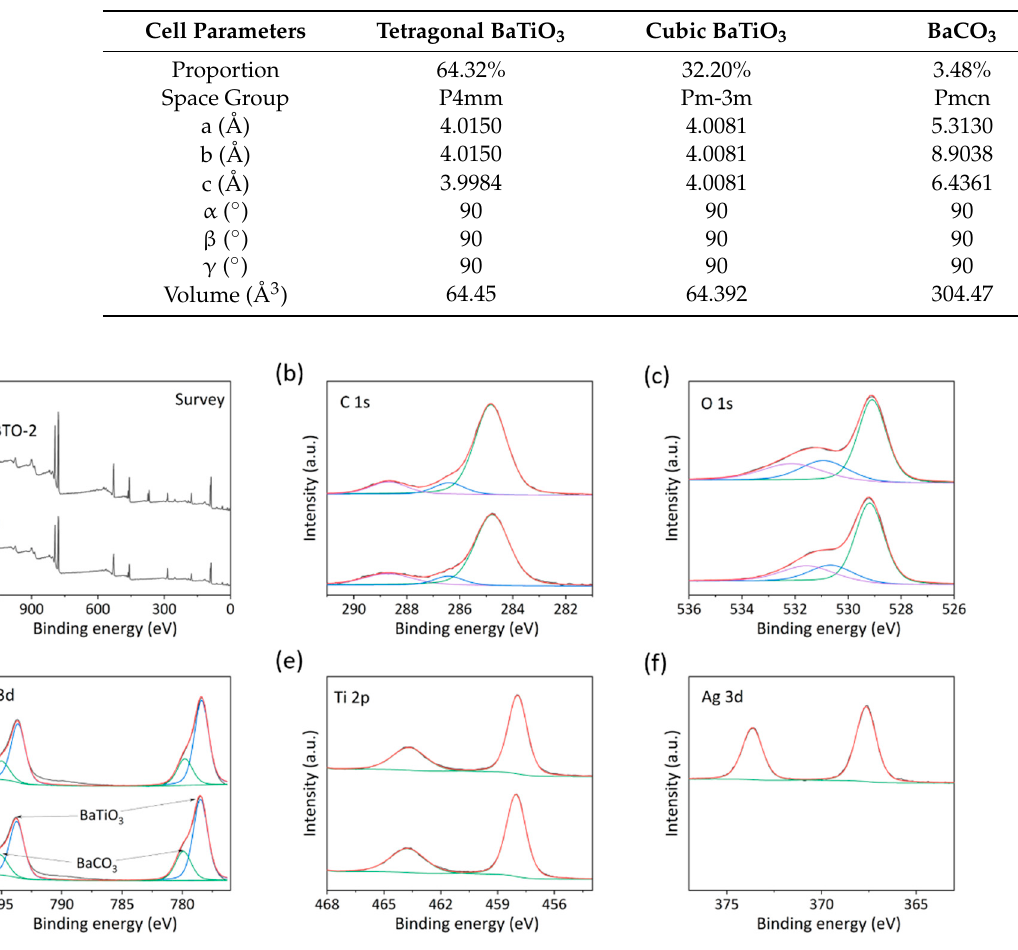
Table 1. Rietveld refined cell parameters of the synthesized BTO nanofibers.